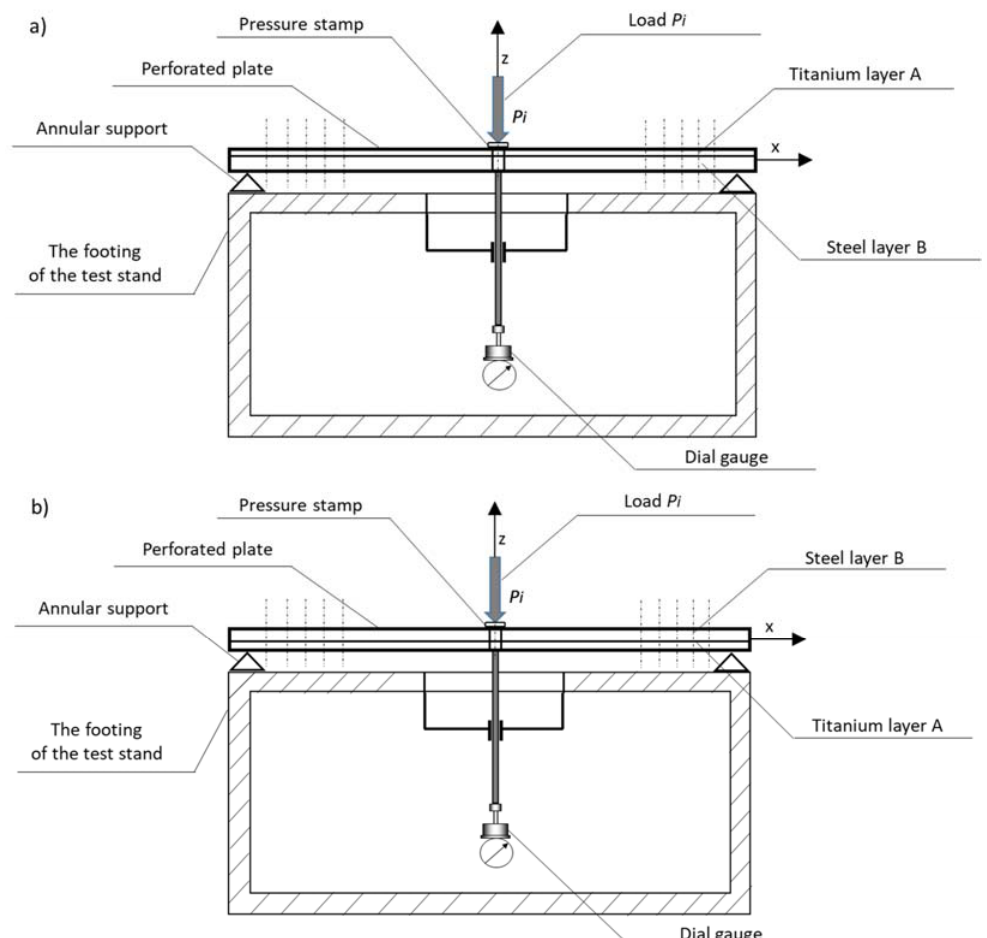
Figure 7: Scheme of a steel – titanium circular perforated plate mounted on a ring support and loaded with a concentrated force P i applied in the geometric center of the plate normally to its surface: a) from the layer of the applied plate A - titanium; b) from the side of the base layer of the B plate - steel, where: 1 – bimetallic circular perforated plate, 2 - the applied layer of the plate A - titanium, 3 - base layer of the plate B - steel, 4 - annular support, 5 - stand support, 6 - P i load, 7 - dial gauge, 8 - pressure stamp.